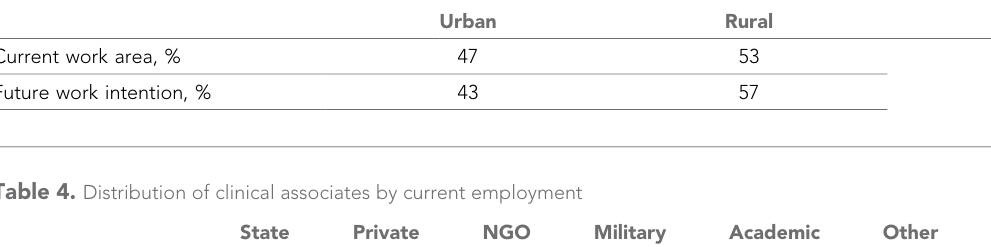
Table 3. Distribution of clinical associates across urban and rural regions